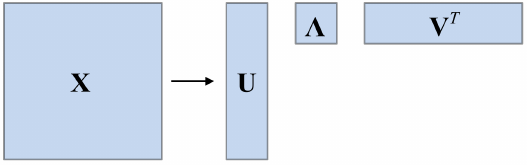
Figure 2. Illustration of SVD approximation.